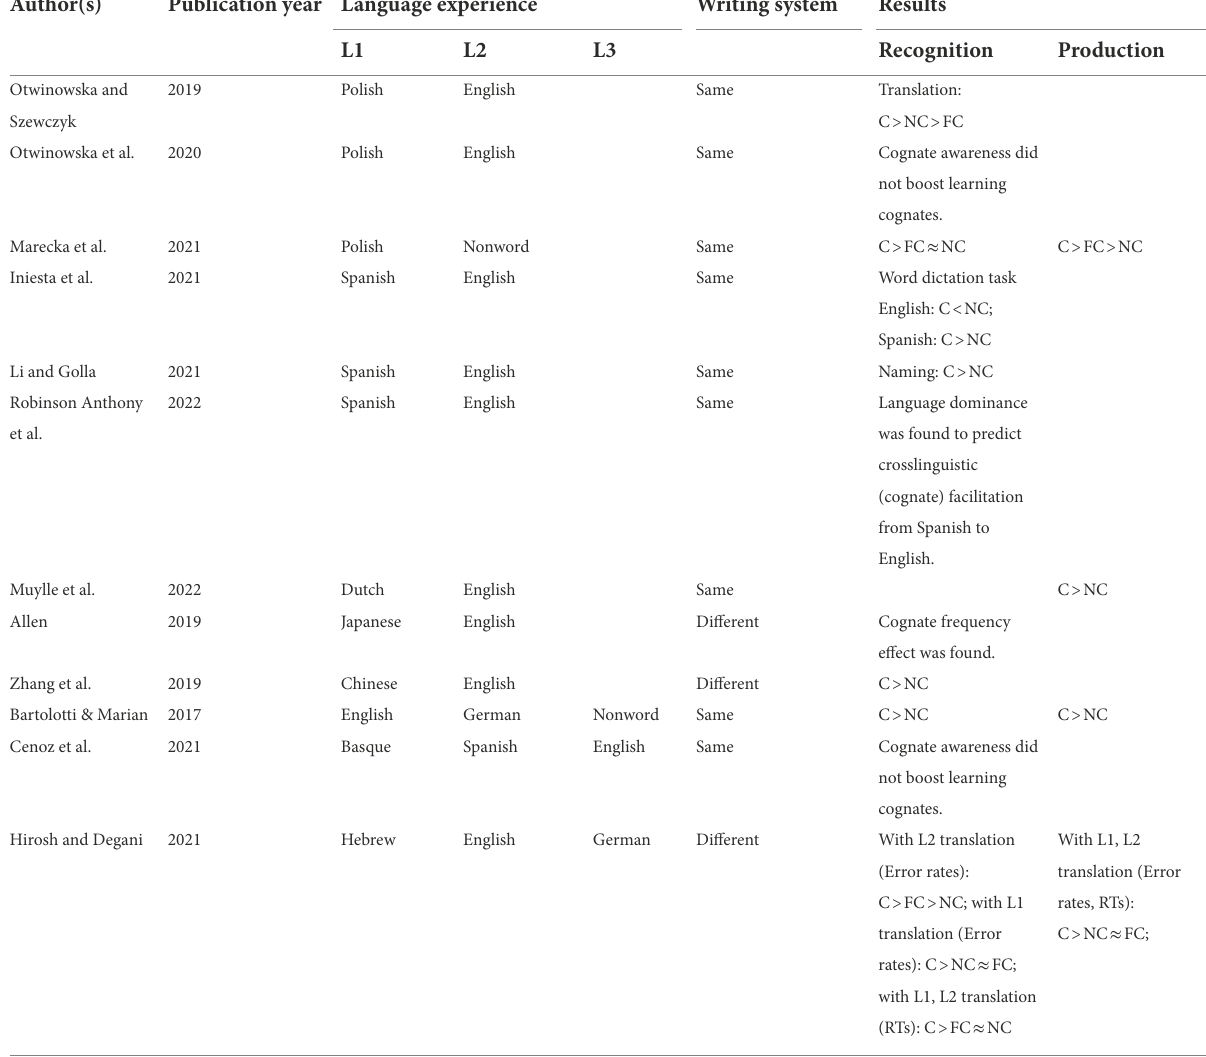
TABLE 1 Major relevant articles concerning form-meaning mapping since